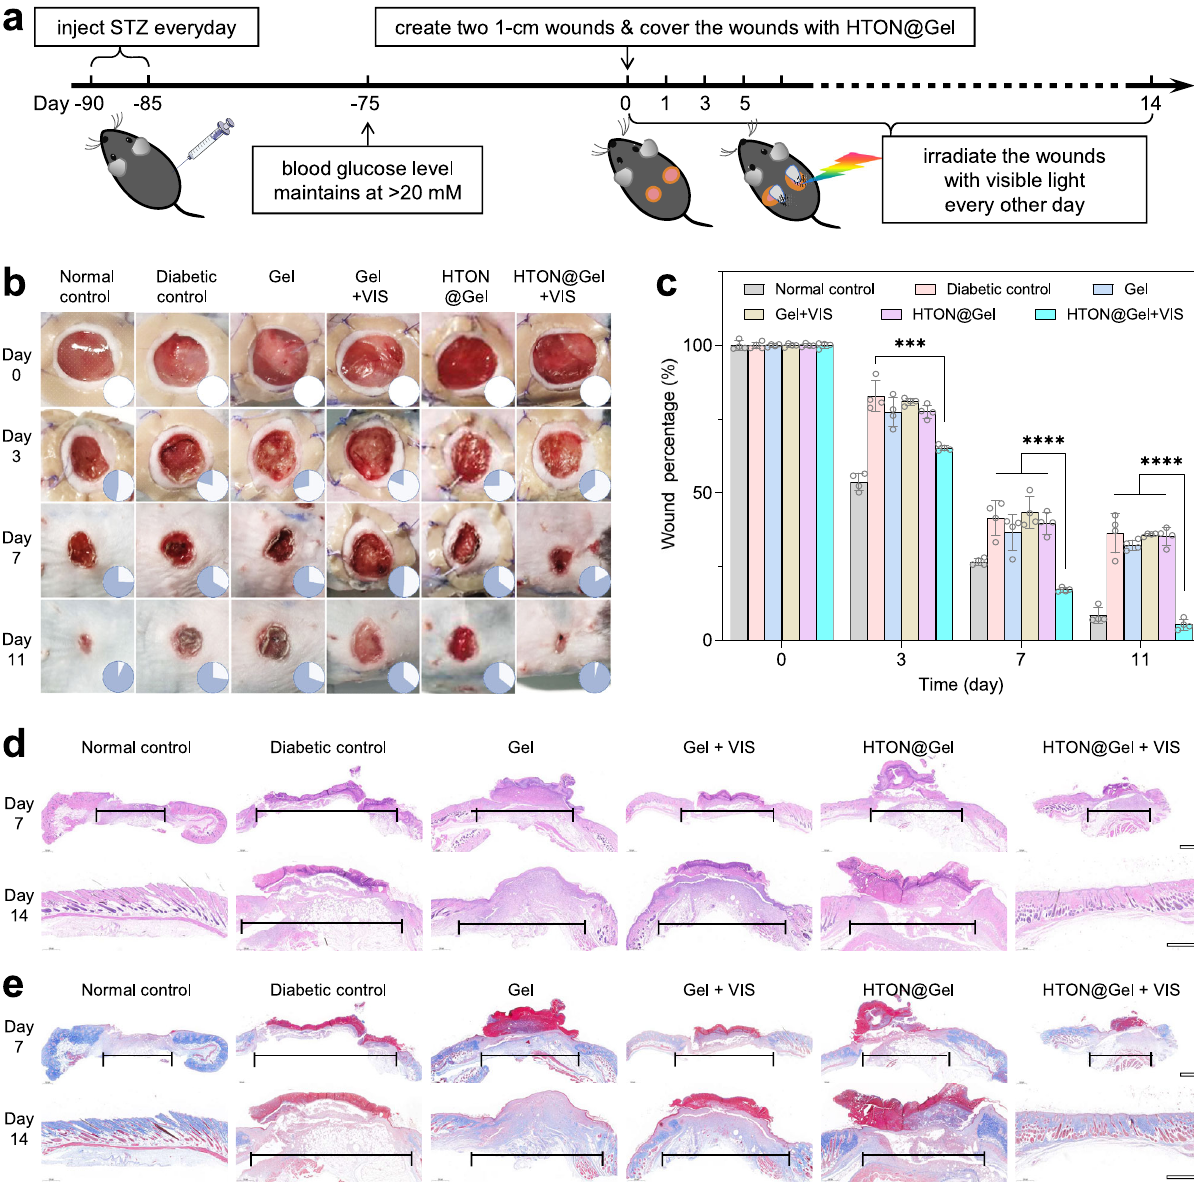
day 7 and day 14. Scale bars in d , e , 1000 μ m. P values were calculated by the one- way ANOVA method (*** P =0.003; **** P <0.0001). Data were presented as mean value±SD.Theexperimentsfor d , e